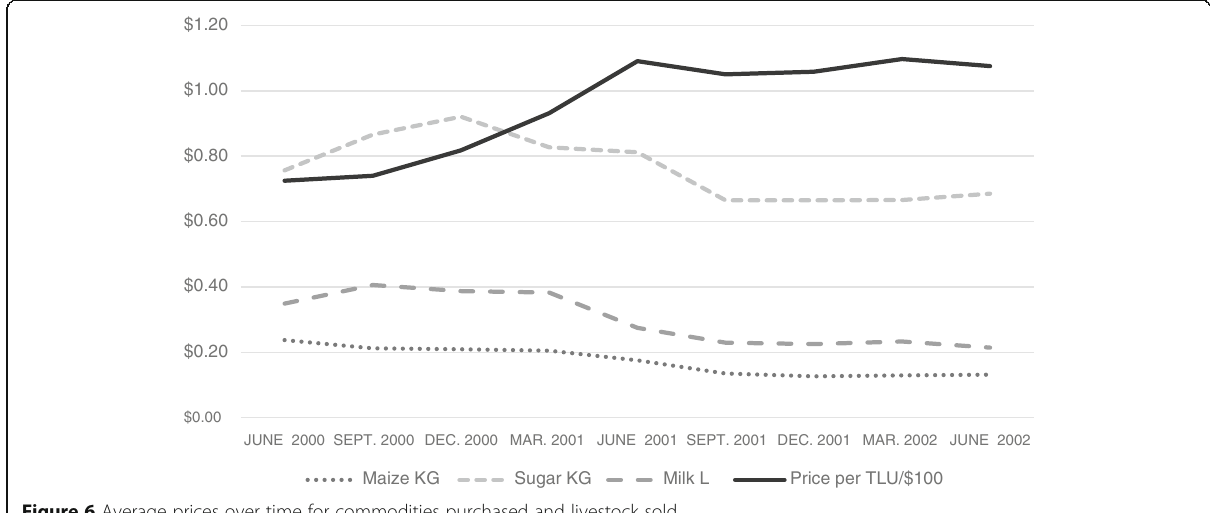
Figure 6 Average prices over time for commodities purchased and livestock sold